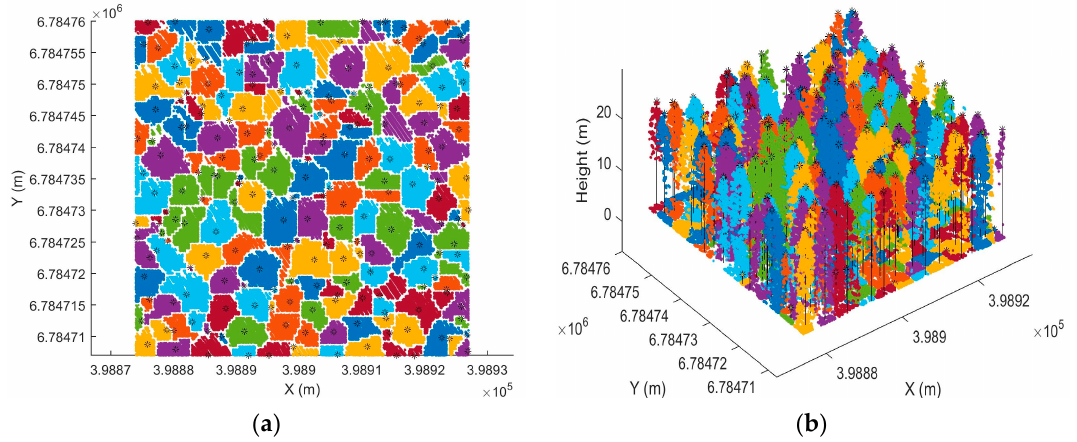
Figure 2. Result of individual tree detection for one plot. ( a ) top view, ( b ) 3D view.